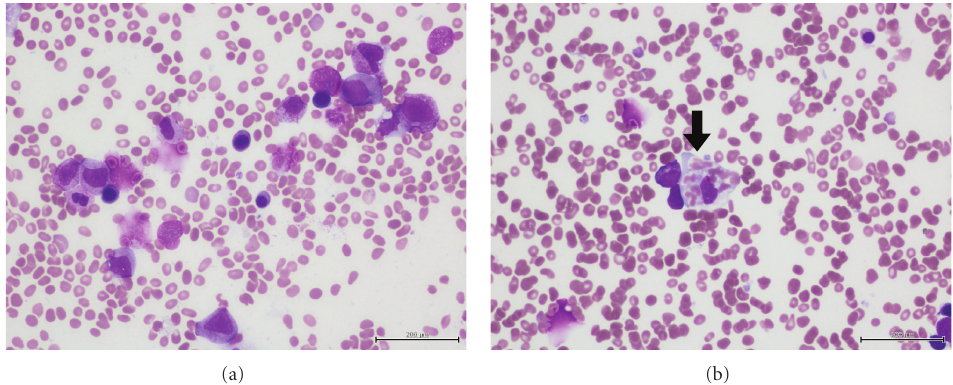
Figure 1: Bone marrow aspirate showed no residual CLL (a) but instead hemophagocytosis